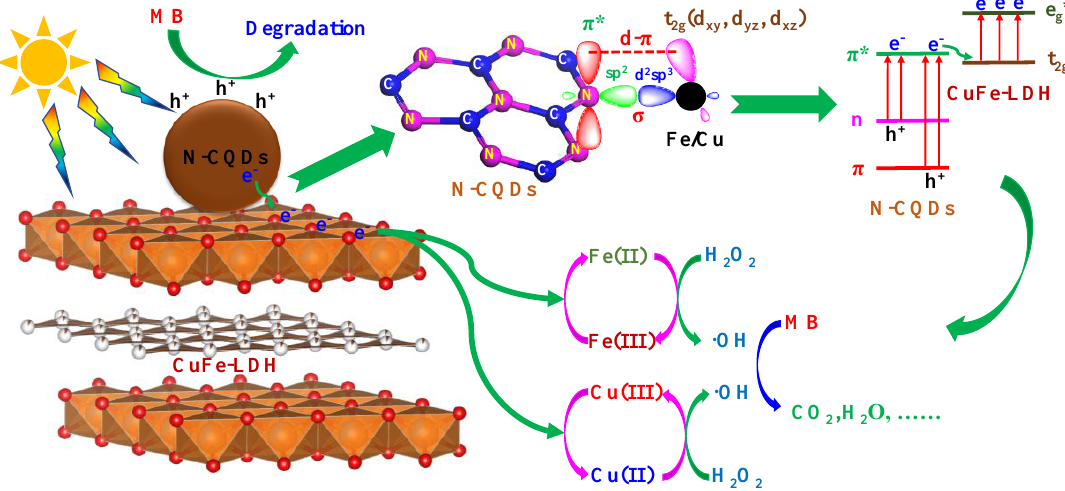
Figure 11. Proposed mechanism of the charge transfer in CuFe-LDH / N-CQDs for the photo-Fenton degradation of MB dye under solar irradiation.